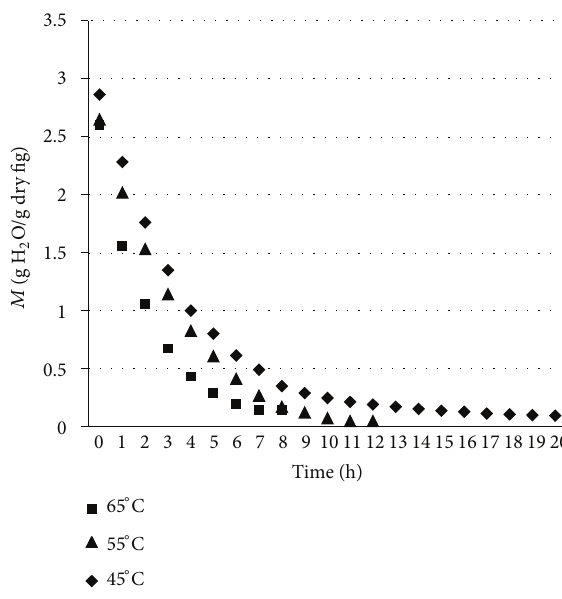
Figure 2: Effect of different temperatures in drying of ground fig (final moisture contents 9.8±1.5 , 4.9±1.1 , and 8.0±2.8 % at 45 ∘ , 55 ∘ , and 65 ∘ C, resp.).